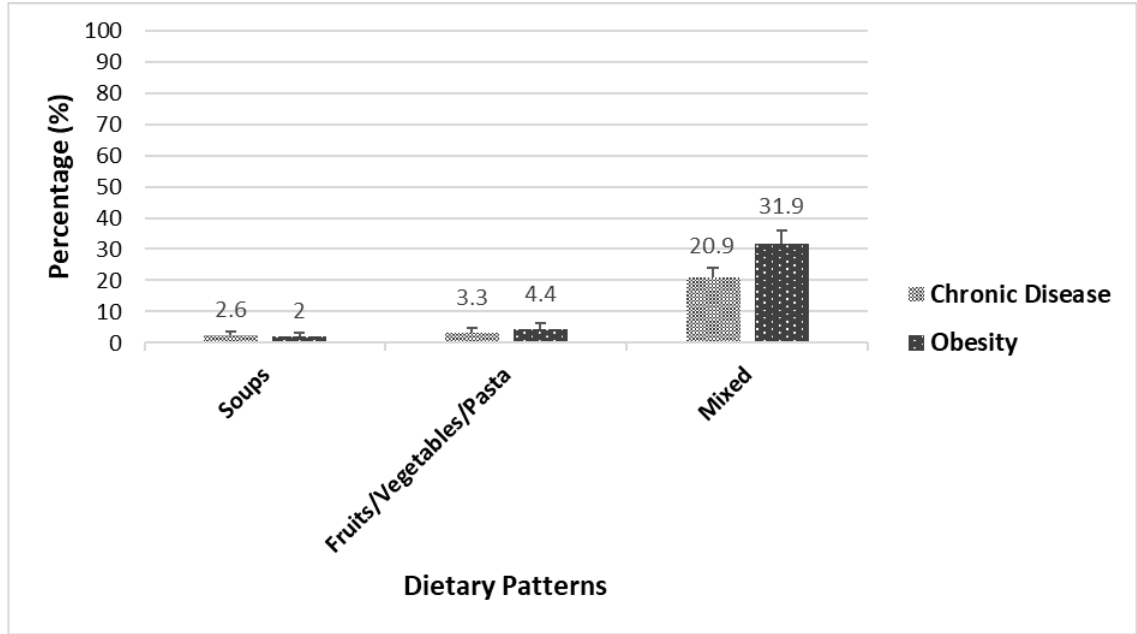
Figure 1. Prevalence of chronic diseases and obesity across dietary patterns among Indigenous adults in 2004.